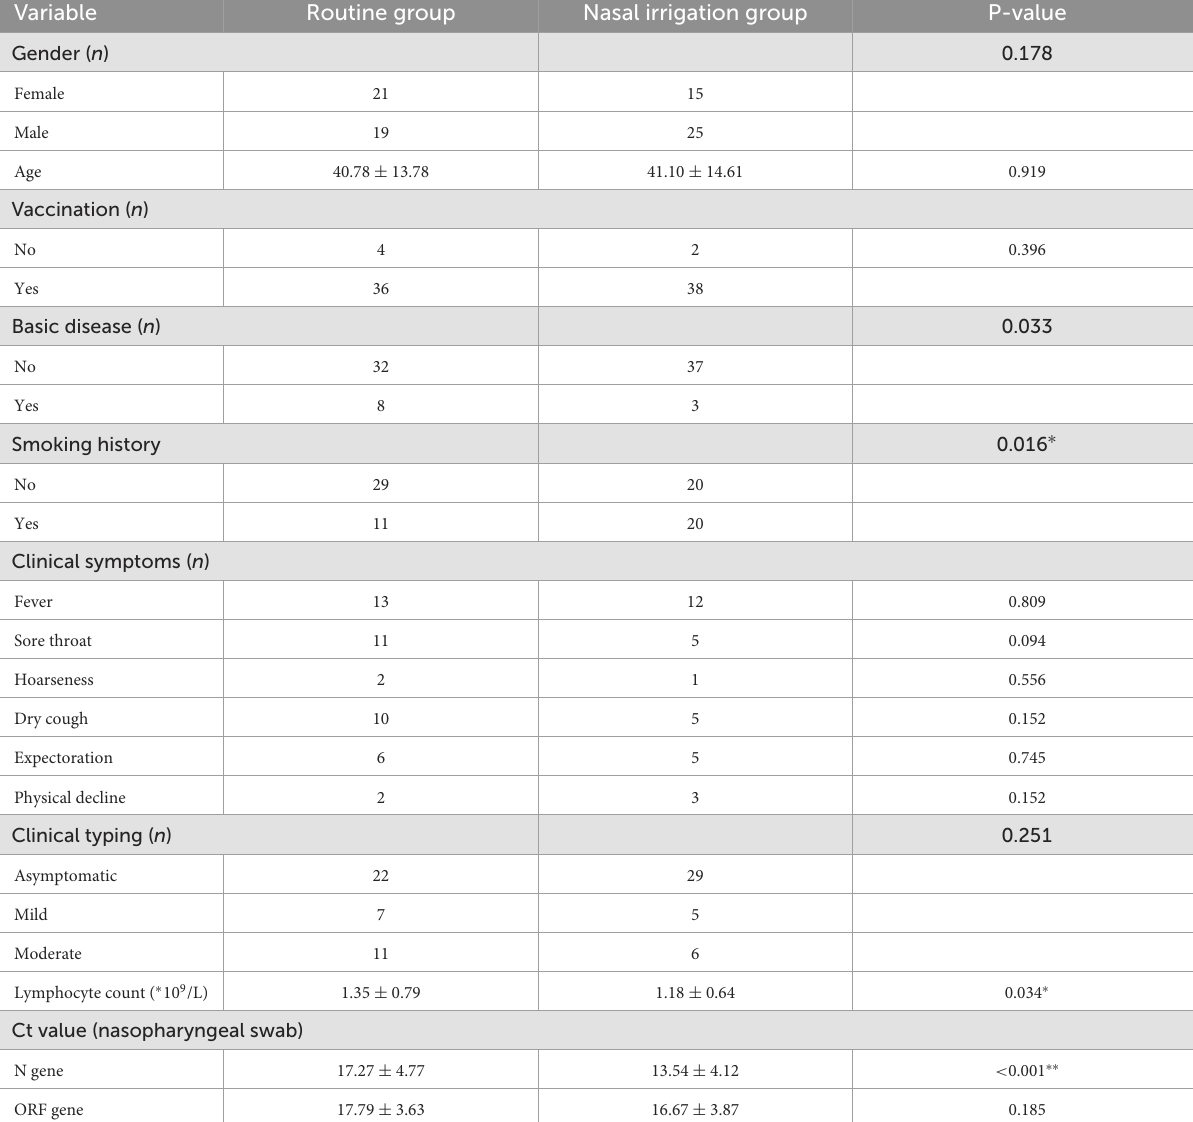
TABLE 1 Comparison of clinical characteristics between the routine group and nasal irrigation